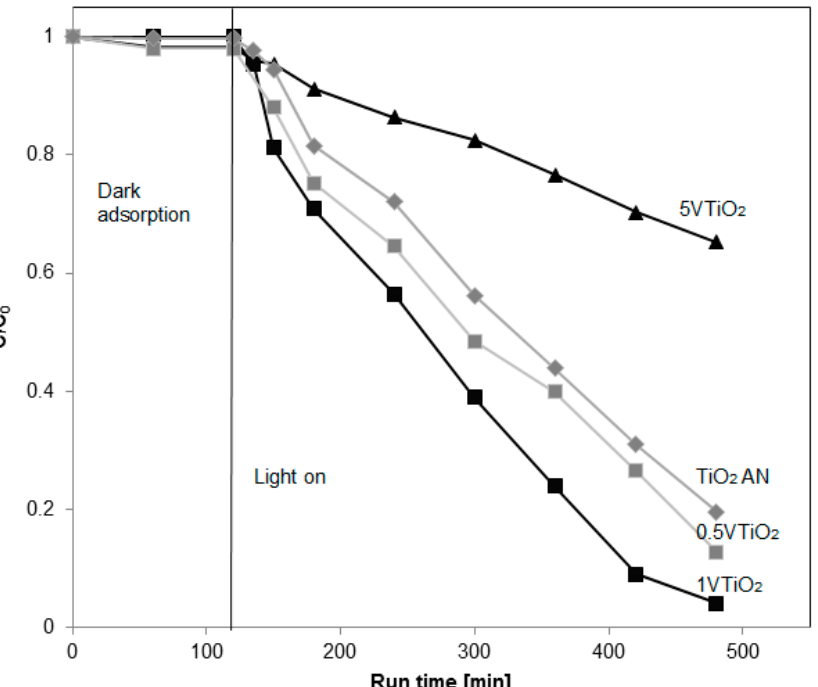
Figure 5. Photocatalytic degradation of caffeine using TiO 2 AA and doped VTiO 2 (0.5VTiO 2 , 1VTiO 2 and 5VTiO 2 ) under UV irradiation .